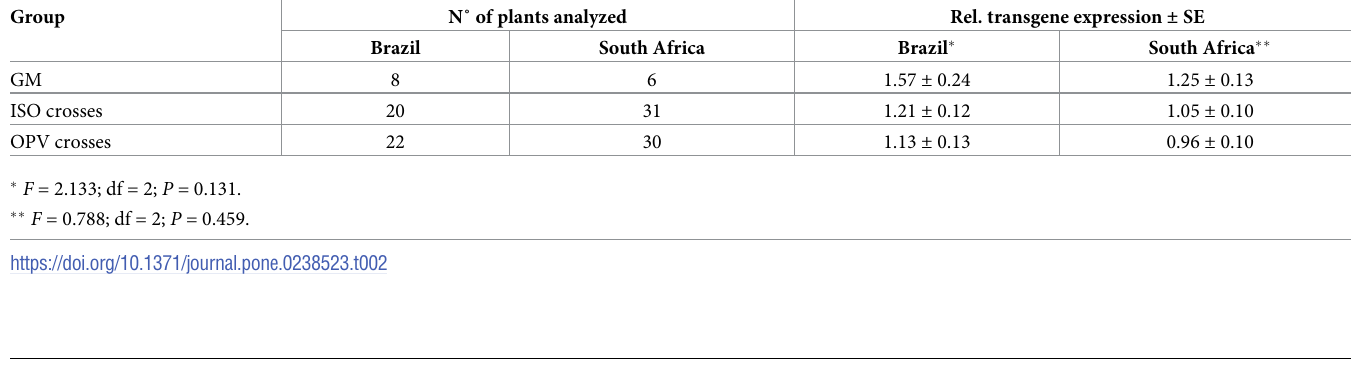
Table 2. Number of maize plants analyzed, mean and standard error ( ± SE) of relative transgene transcription activity in different groups from Brazil and South Africa. Group